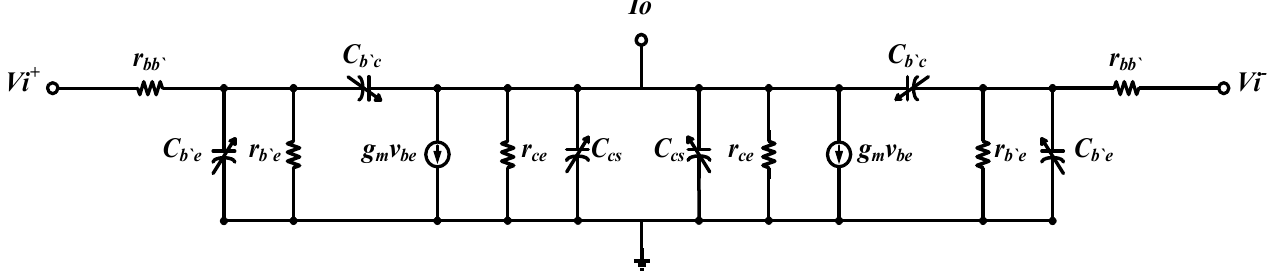
Figure 5. The collectors of the two HBTs devices are connected to form nonlinear capacitors by the differential voltage source.